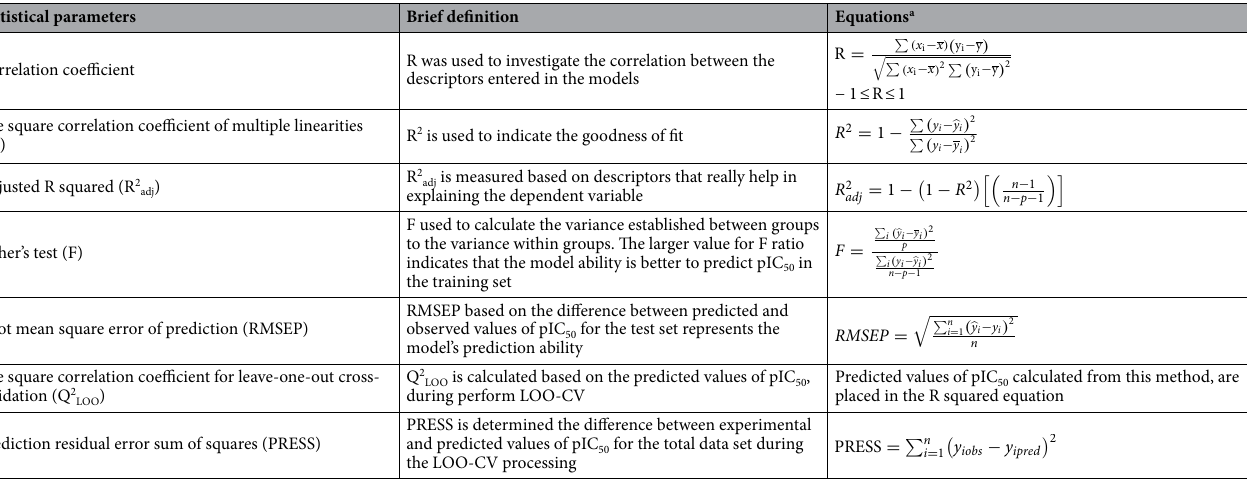
Q 2 LOO is calculated based on the predicted values of pIC 50 , during perform LOO-CV PRESS is determined the difference between experimental and predicted values of pIC 50 for the total data set